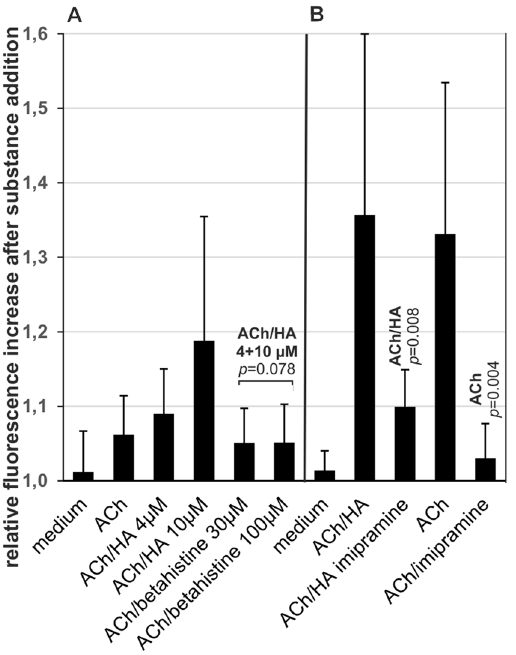
Figure 6. Effect of betahistine and imipramine on the [Ca 2 + ] i response evoked by ACh/HA or ACh alone (age of culture > 1 year). Fluorescence enhancement was measured 10 s after addition of 200 µ l medium containing ACh or ACh/HA and the indicated substances. Statistical significance compared to the treatment group indicated on top of the bar was calculated by univariate analysis with the Mann-Whitney U -test. Mean values and standard deviations were calculated from at least 6 experiments. ( A ) Comparison of the effects of betahistine and HA. Betahistine or HA were added to the cells simultaneously with ACh (final concentration 1 µ M, 6 experiments) at the indicated final concentrations. As indicated by the bracket, in the Students’s t-test all betahistine samples, irrespective of betahistine concentration, were compared to the samples with HA added to a final concentration of 10 µ M. ( B ) Effect of imipramine. Imipramine was added simultaneously with ACh/ HA (final concentrations 1 and 10 µ M, respectively, 6 experiments) or with ACh (final concentration 2 µ M, 7 experiments) as indicated. Note that ACh in the absence of HA was used at a concentration of 2 µ M to attain a similar response as in the presence of HA for better comparability of the inhibitory capacity of imipramine.